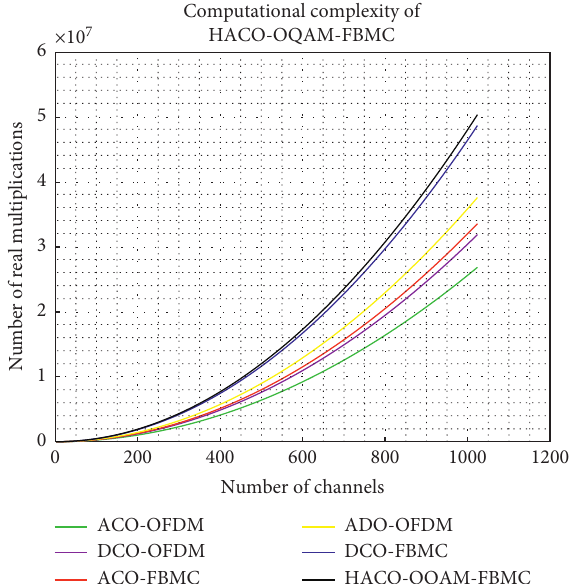
Figure 11: Spectral efficiency of HACO-OQAM-FBMC, ACO- OFDM, DCO-OFDM, EHACO-OFDM, DCO-FBMC, and ACO- FBMC.